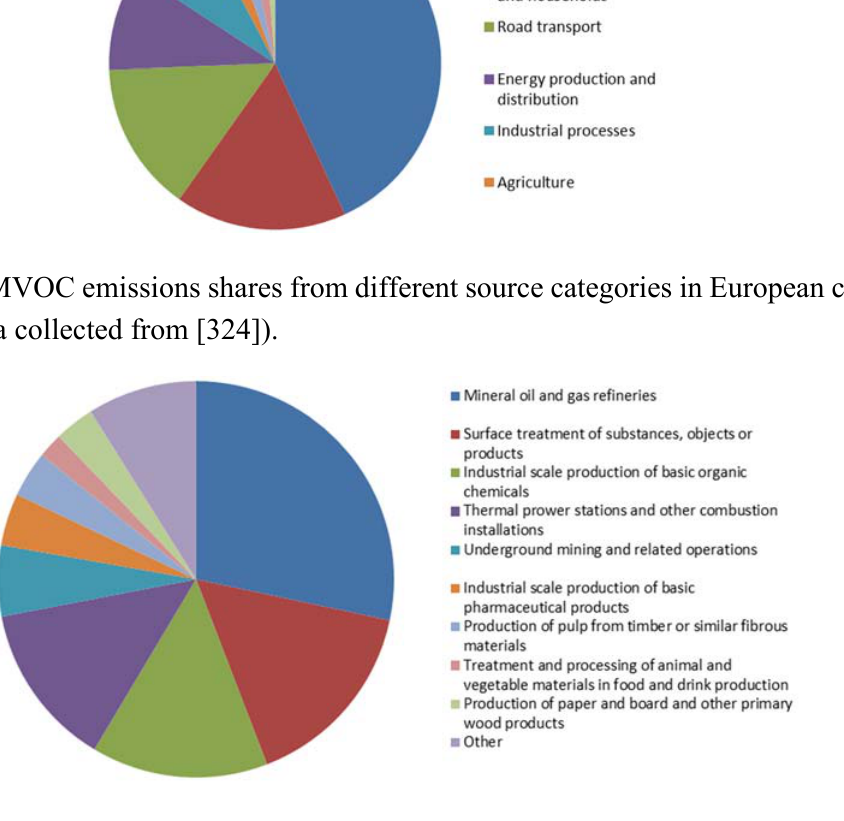
Figure 5. NMVOC (Non-Methane VOC) emission shares from European industrial facilities in 2012 (Data collected from: